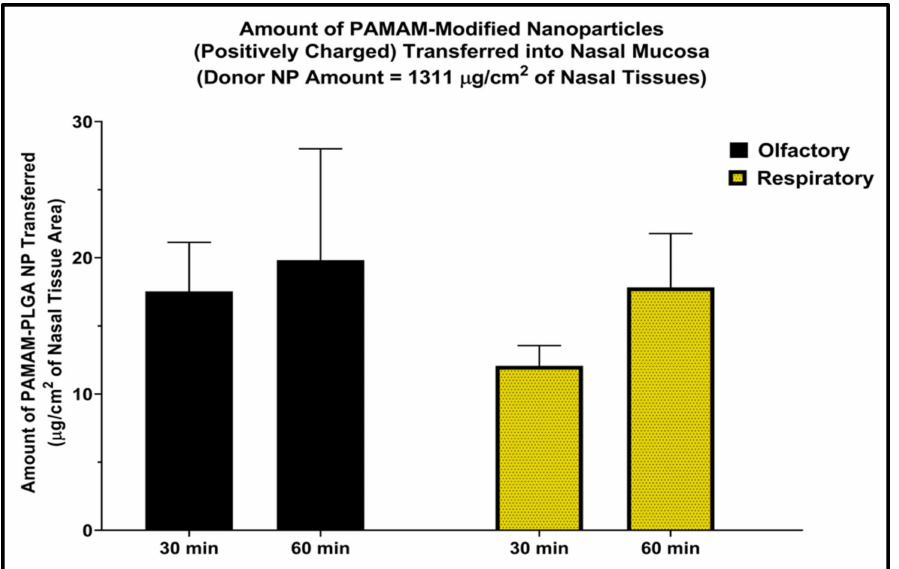
Figure 2. Amount of nanoparticles in the nasal mucosa after incubation with PAMAM-modified nanoparticles (cationic PLGA NP) for 30 and 60 min normalized per tissue surface area. The two tailed t -test was applied to evaluate the statistical significance. n = 3 each, bars represent mean ±